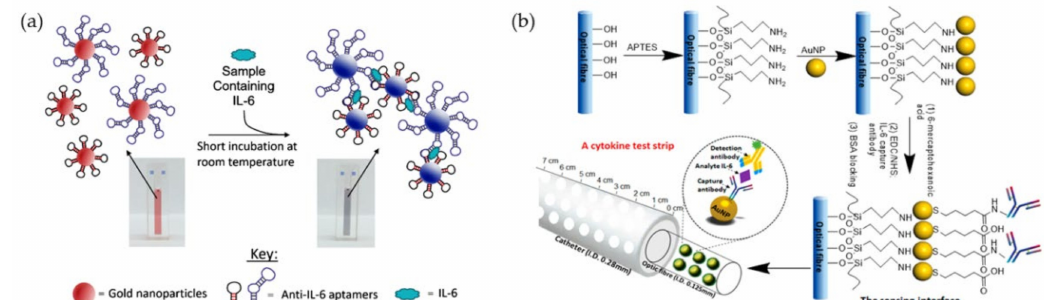
Figure 2. Illustration for some examples of the developed AuNPs-based cytokine biosensors. ( a ) A schematic of the aptamer-AuNPs-based aggregation assay for the IL-6 detection. Reproduced with permission from Ref [70]. Copyright 2019, Giorgi-Coll et al. ( b ) Scheme of the cytokine test strip preparation based on the optical fiber for IL-6 detection. Reproduced with permission from Ref [73]. Copyright 2016, American Chemical